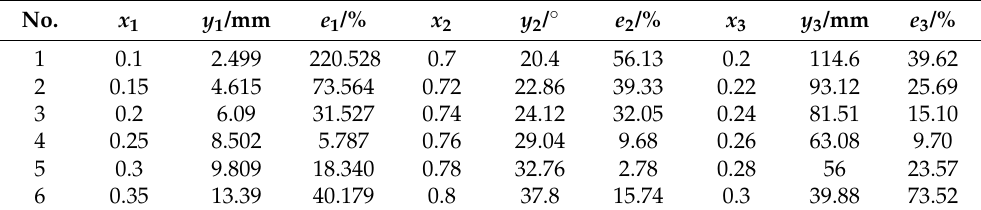
Table 4. Test design and results.